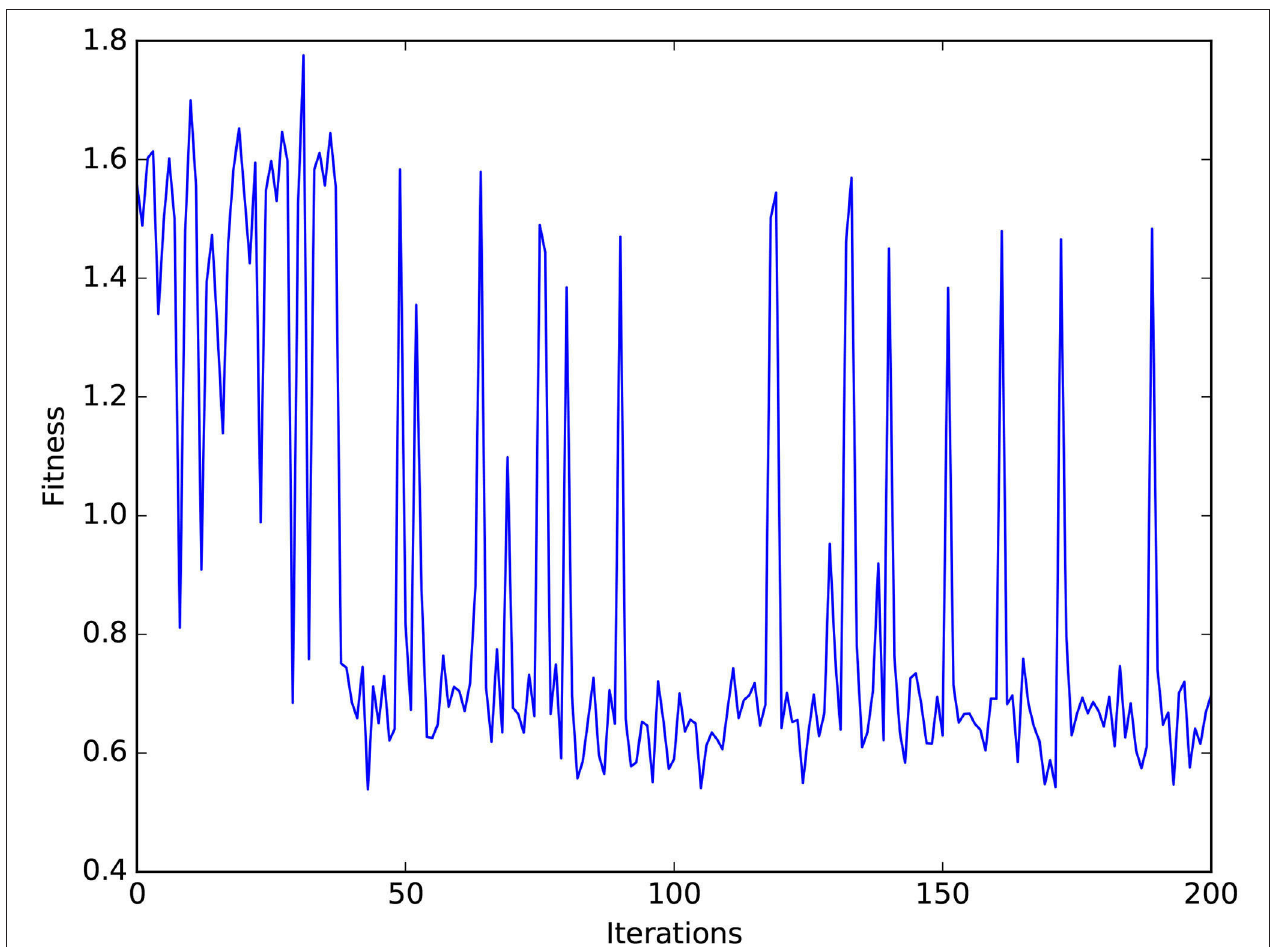
FIGURE 12 | Values of the fitness function vs. the number of optimization